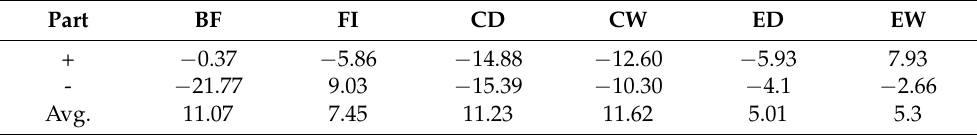
Table 6. MAPE (Equation (14)) in % (results from models calibrated in both IP and OoP direction).